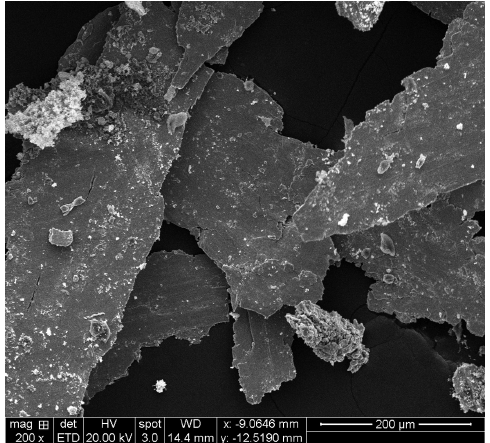
Figure 7 SEM of wear debris collected during wear